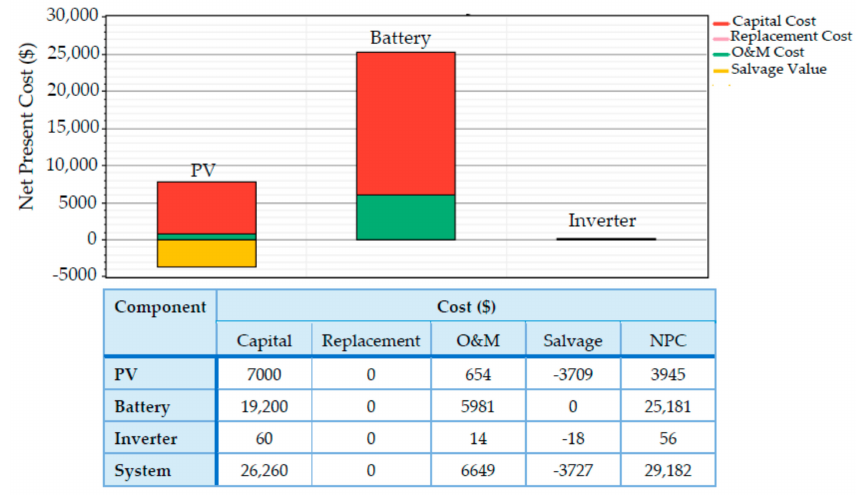
Figure 15. Summary of the net present cost for the system’s